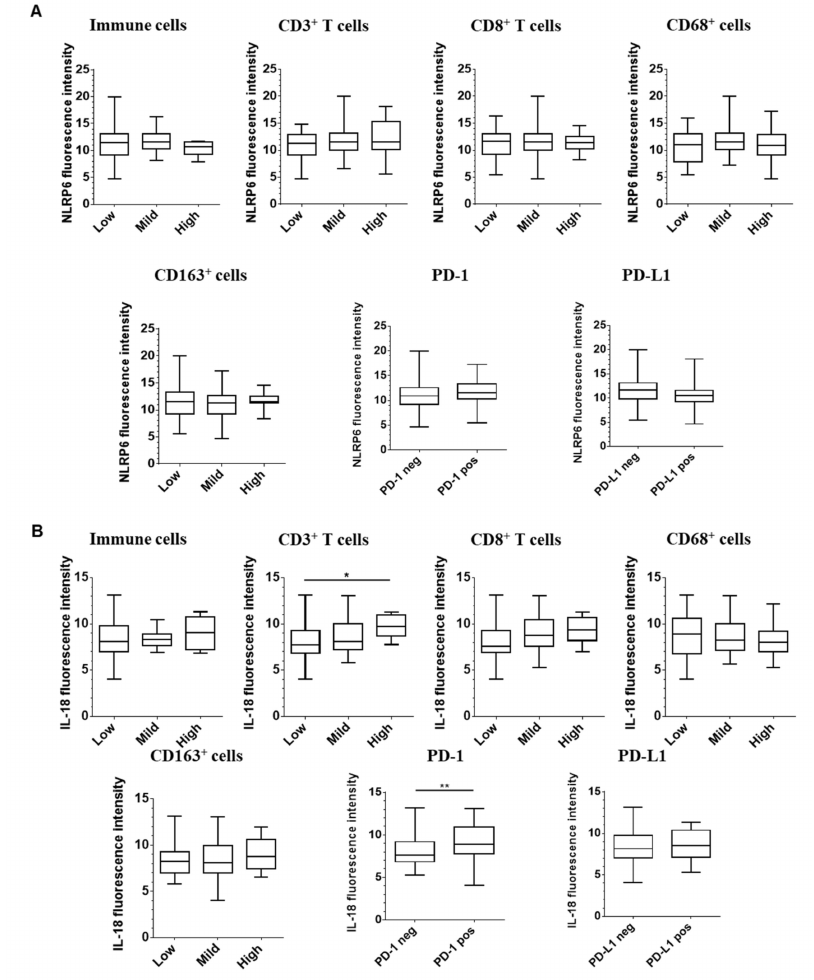
Figure4. ExpressionofepithelialIL-18iscorrelatedwithhigherlymphocyteinfiltrationwithincolorectal tumors. For each protein, we assessed the correlation between fluorescence intensity of inflammasome component NLRP6 ( A ) or IL-18 ( B ) and immune infiltration assessed by immunohistochemistry for T cell lymphocytes (CD3 + and CD8 + ) and macrophages (CD68 + and CD163 + ). We also evaluated PD-1 and PD-L1 expressions. A one-way ANOVA (parametric) or a Kruskal-Wallis test (non-parametric) were used to evaluate the correlation between expression intensity and immune infiltrate levels. * p < 0.05 and ** p <